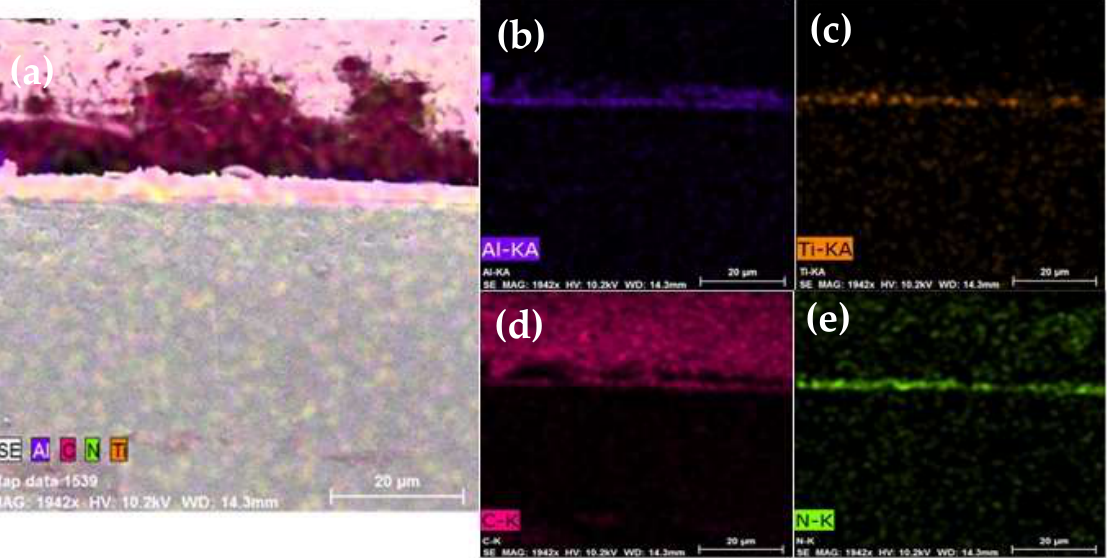
Figure 4. EDS analysis of the layout of individual elements in the TiAlCN layer ( a ), elemental distribution of Al ( b ), Ti ( c ), C ( d ) and N ( e ).